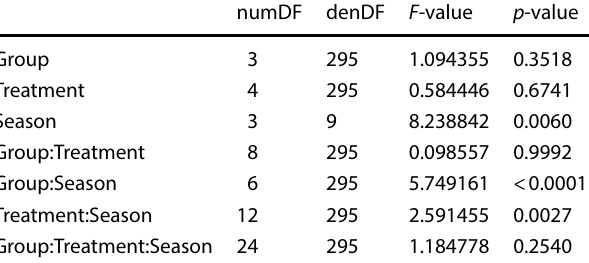
Table 5 The LMEM for three-way interaction model numDF denDF F -value p -value